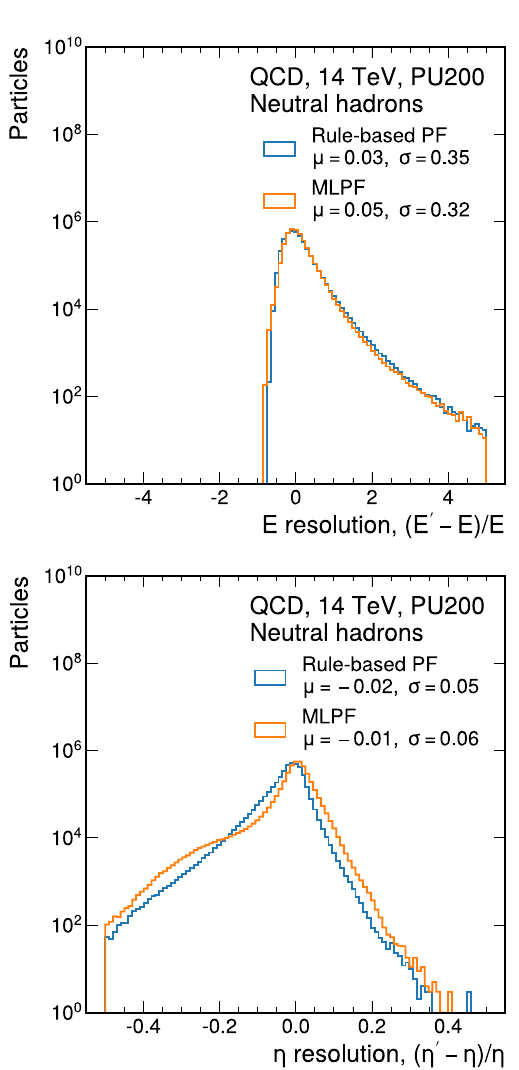
Fig. 9 The p T and η resolution of the delphes PF benchmark and the MLPF model for charged hadrons in simulated QCD multijet events with PU. The p T resolution is comparable for both algorithms, with the angular resolution being driven by the smearing of the track (η,φ) coordinates